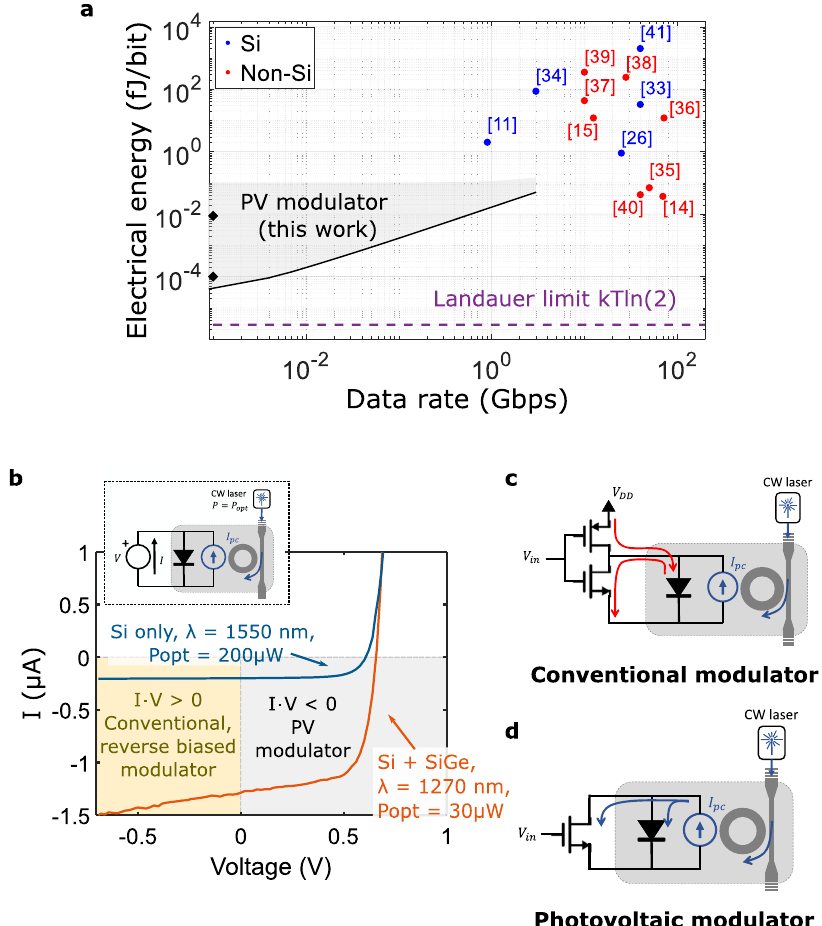
Fig. 2 Photovoltaic modulation working principle. a Electrical energy consumption and demonstrated data rate for the lowest power optical modulators reported in the literature 33 – 41 . Devices fabricated in silicon (blue) and other material platforms (red) are shown. Photovoltaic (PV) modulation (gray shaded area) can achieve orders of magnitude lower power consumption at speeds below ≈ 3 GHz, approaching the Landauer limit for binary switching (dashed purple line). Black diamonds show experimentally obtained optical modulation presented in this work. Supplementary Tables 1 and 2 show more information on the different devices. b Measured I – V curves of two different silicon photonic resonant modulators under illumination. Photocurrent generation is clear. Energy harvesting is possible when operating the device in the gray shaded area, while conventional modulators operate in the yellow shaded area. The inset shows the measurement setup. More information is given in Supplementary Discussion 2. c Conventional modulation